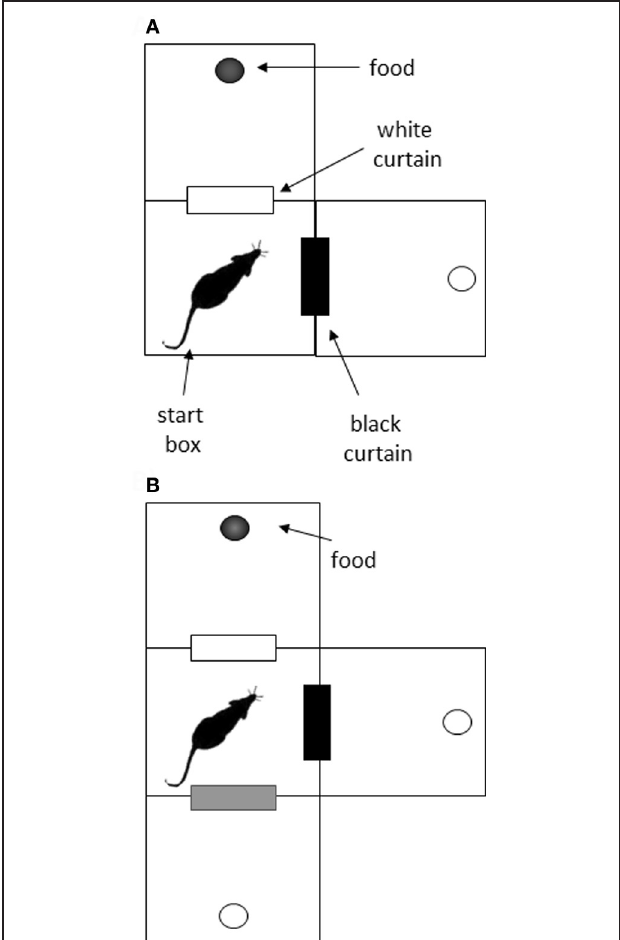
FIGURE 2 | Schematic of the visual discrimination task. (A) In the initial two-choice task, rats were placed in the start box, and had to choose between a doorway with a black curtain and one with a white curtain. Food reward was always associated with one color for each rat. (B) In the three-choice task, an additional doorway was opened, and it was covered with a gray curtain. The previous association (e.g., white curtain—reward) was maintained in the three-choice